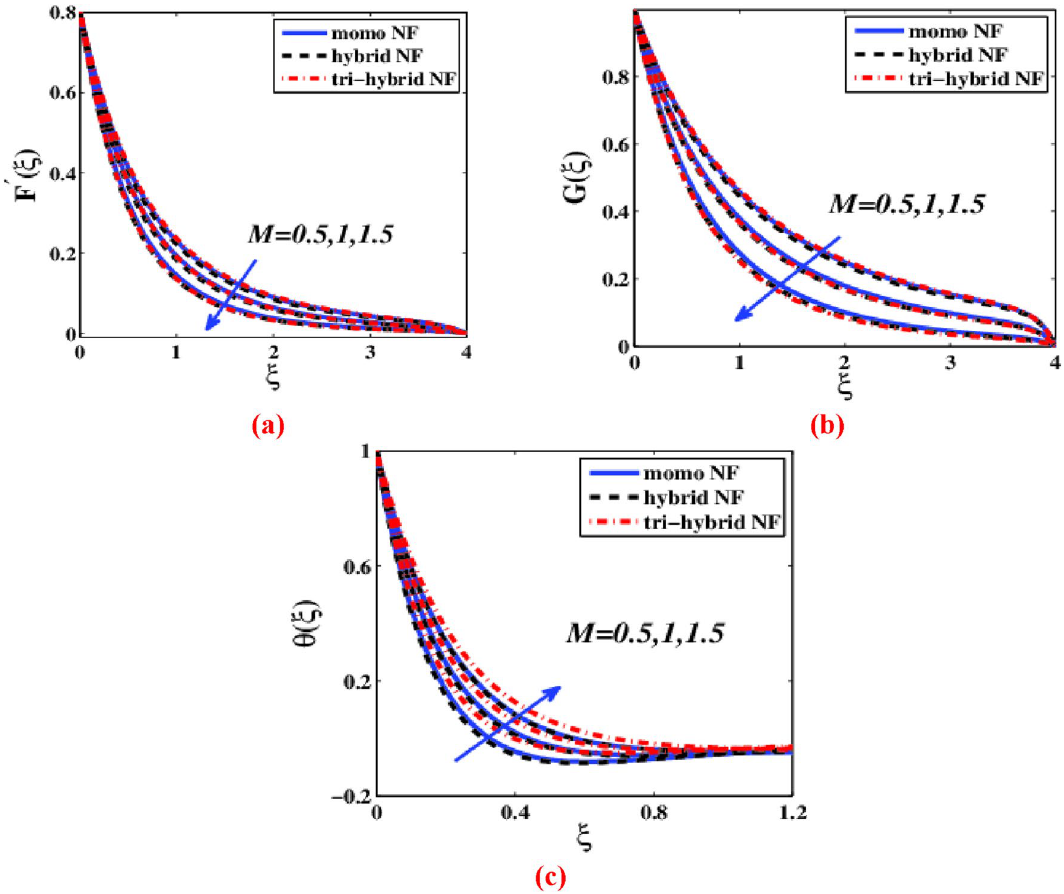
Figure 3. ( a ) F ′ (ξ) , ( b ) G (ξ) and ( c ) θ(ξ) with diverse M